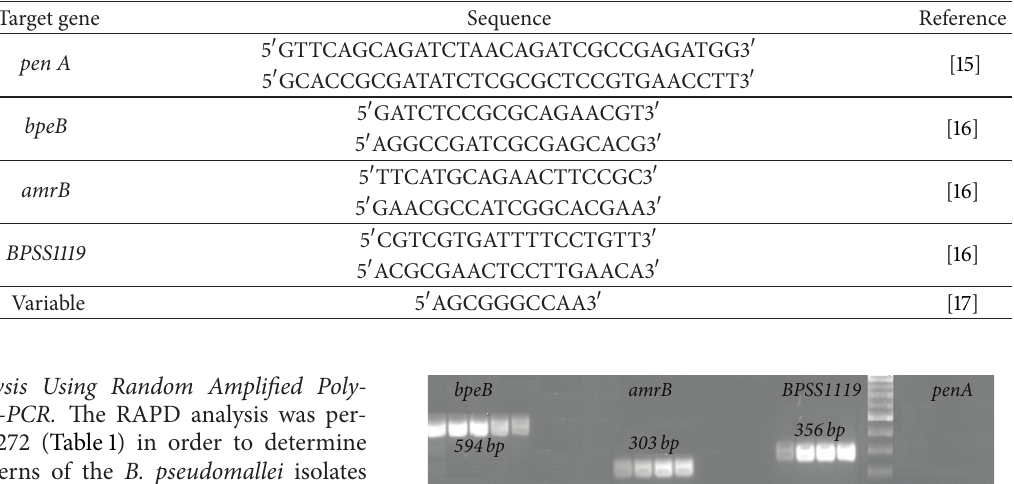
Table 1: Primers used in this study.